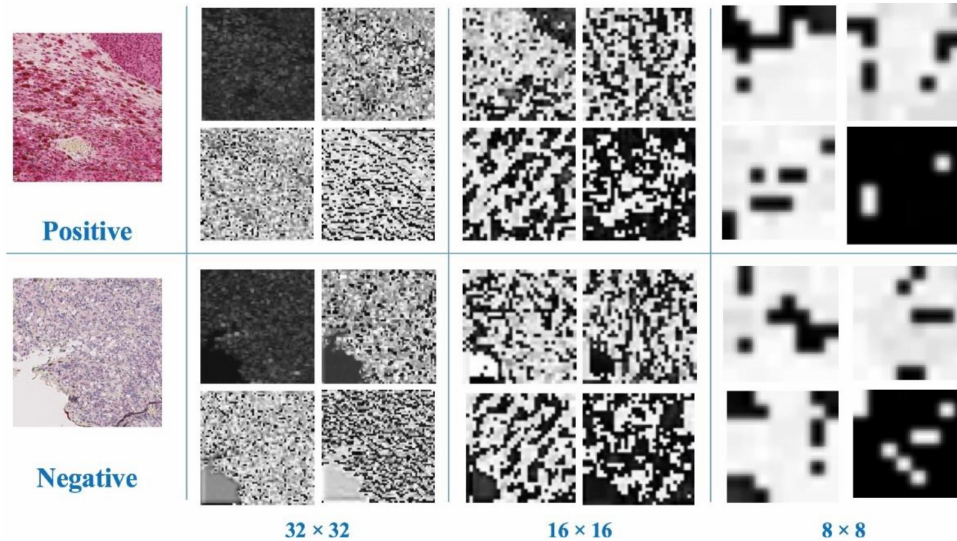
Figure 6. Several samples of convolutional feature maps in our networks with di ff erent downsampling strides. We visualized two groups of feature maps from two categories: positive and negative. With the increase of depth, the feature maps became more abstract from detailed enhancement to global perception. For di ff erent categories, we sampled the feature maps with the same layers and channels (four channels in each layer). The coding of feature maps from the two categories was